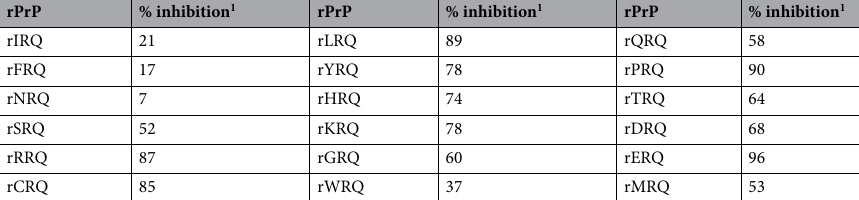
rPrP % inhibition 1